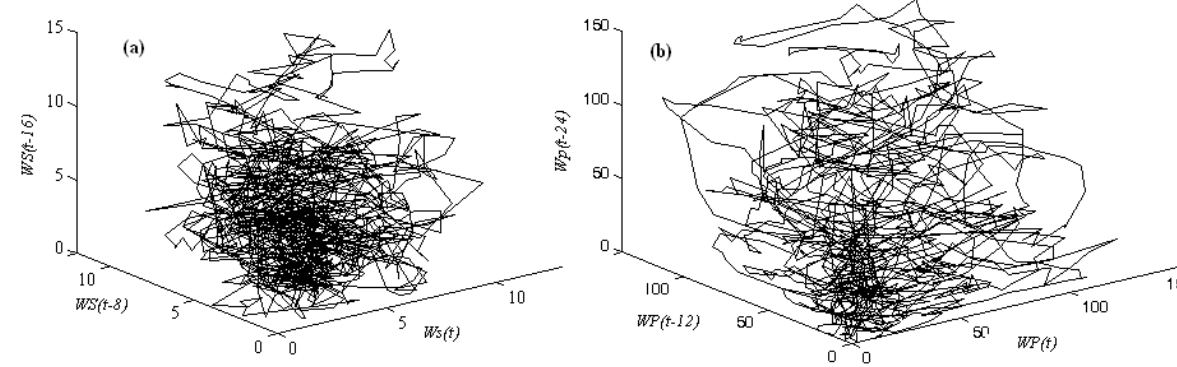
Figure 7.The phase space plot of (a) the wind speed time series ( 8 τ  ), (b) the wind power time series ( 12 τ  ).